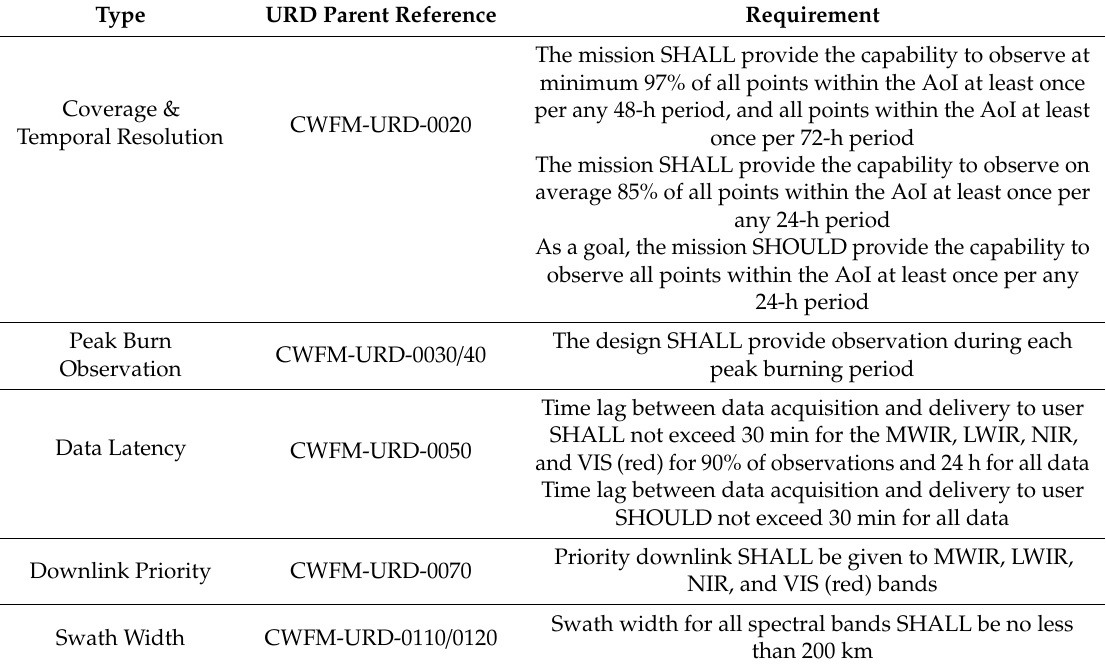
Table 4. Summary of key Observational (coverage and latency) Requirements as outlined in the User Requirements Document (URD), and refined in the Mission Requirements for WildFireSat. AoI refers to the Area of Interest (Figure 2). See Table 5 for spectral band